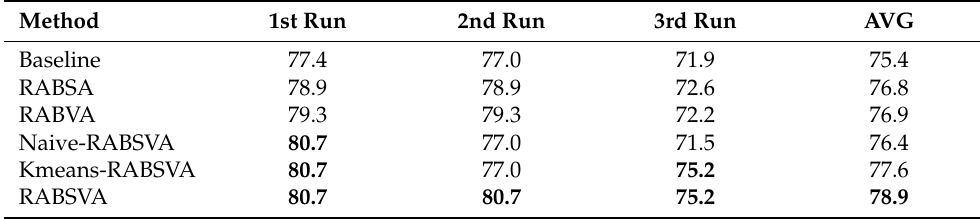
Table 1. The top-1 performance of 5-shot using 3D ResNet-50 as backbone on HMDB-49.